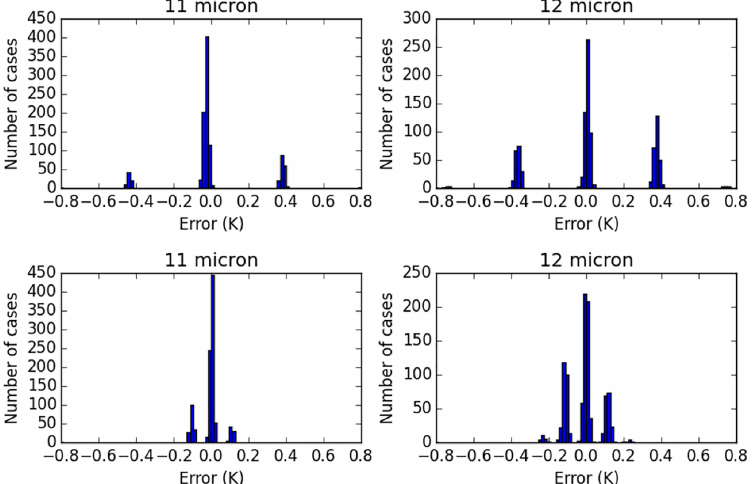
Figure 3. Distributions of single-pixel brightness temperature (BT) errors from a simulation for the detection and calibration system of an advanced very high resolution radiometer (AVHRR) for channels of different wavelength (columns) and two scene temperatures (upper row 200K scene, lower row 300K scene). The unit of frequency of occurrence is per